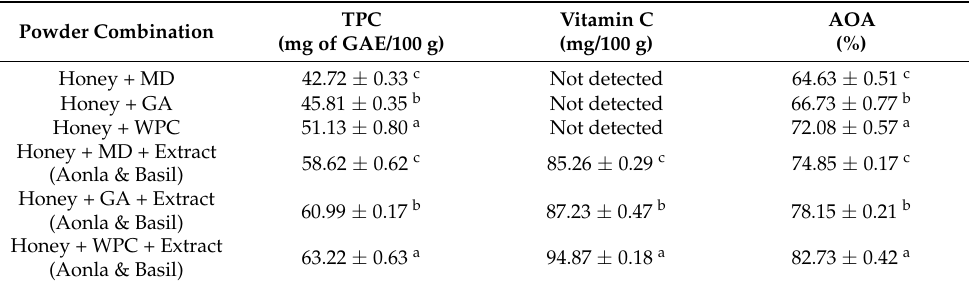
Table 5. Total phenolic content (TPC), vitamin C content, and antioxidant activity (AOA) of spray- dried honey powder fortified with different carriers as assessed by Duncan’s multiple range test.